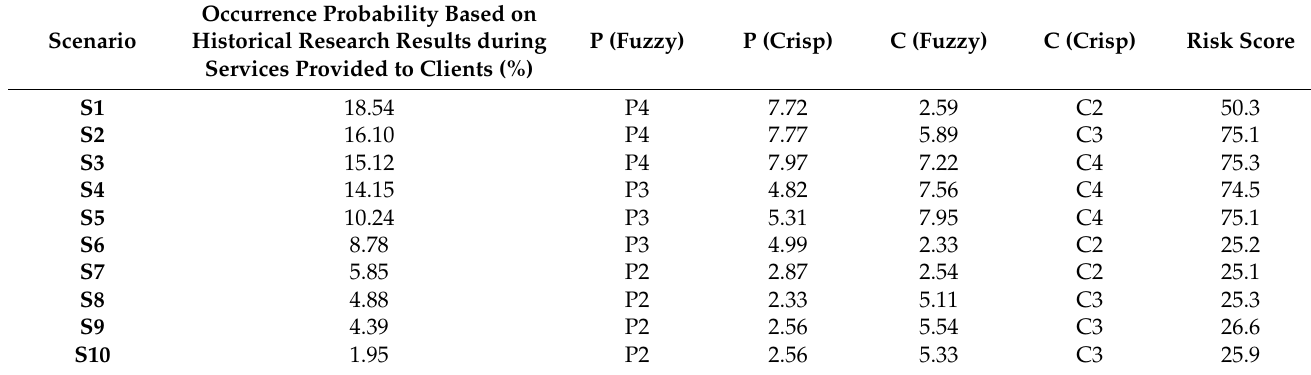
Table 9. Results of empirical experiments and risk score for all considered scenarios. All rules are with weight = 1.